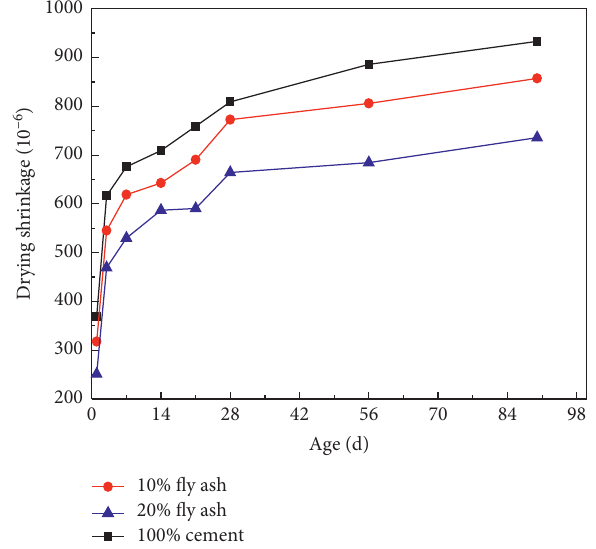
Figure 18: Effect of PCE-2 and fly ash dosage on drying shrinkage of cement